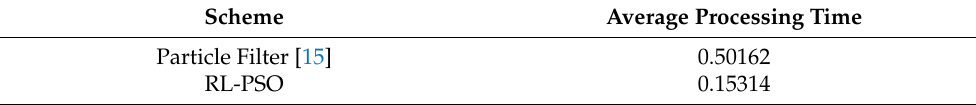
Table 4. Comparison of average processing time of each scheme to achieve positioning error of 1 m. Scheme Average Processing Time Particle Filter